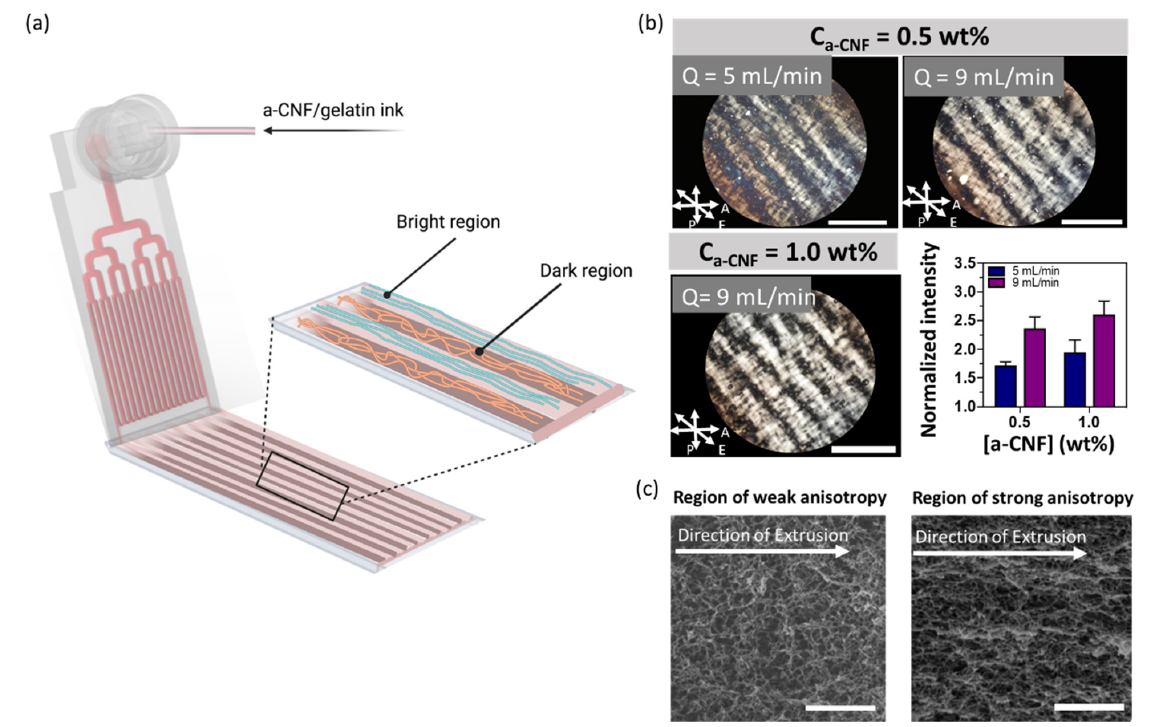
Figure 3. Microfluidic extrusion-based printing of structurally anisotropic hydrogel sheets. ( a ) Schematic depicting printing of a hydrogel sheet. ( b ) POM images of the extruded hydrogel at C gelatin = 4.0 wt.%. Top left: C a-CNF = 0.50 wt.%, Q = 5.0 mL/min. Top right: C a-CNF = 0.50 wt.%, Q = 9.0 mL/min. Bottom left: C a-CNF = 1.0 wt.%, Q = 9.0 mL/min. Scale bars are 2 mm. Bottom right: Average light intensity of the bright stripes normalized to the dark stripes at different C a-CNF (C gelatin = 4.0 wt.%) and flow rates Q. Each bar represents three independently examined hydrogels. The arrows in the image depict the direction of extrusion (E) and the direction of the polarizer (P) and analyzer (A) with respect to the direction of extrusion. ( c ) SEM images of extruded hydrogel sheets in the region of weak and strong anisotropy. The gel was extruded at Q = 9.0 mL/min. C a-CNF = 1.0 wt.%; C gelatin = 4.0 wt.%. Scale bars are 1 μ m.